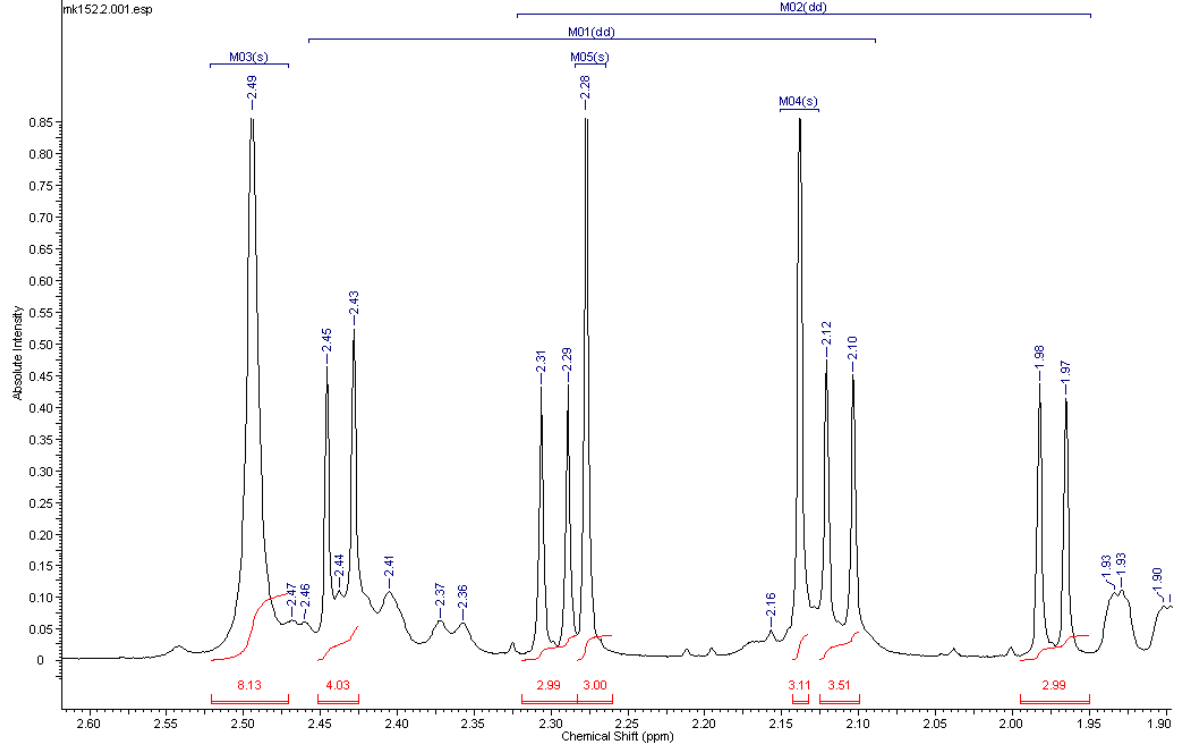
Figure 2. 1 H-NMR analysis of [acetyl- 13 C 4 ]heroin ([ 13 C 4 ]- 4 ) spiked with heroin ( 4